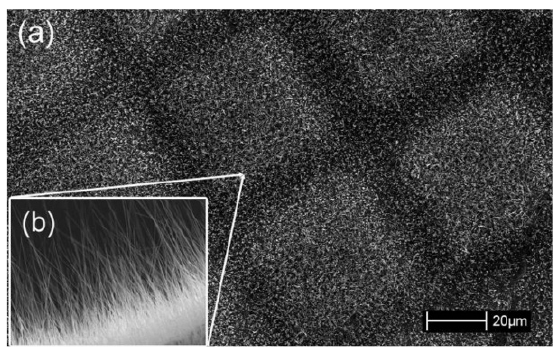
Figure 6. (a) The SEM image of a patterned Cu 2 O nanowire array fabricated by partially covering Cu foil. (b) The SEM image of the side view of these